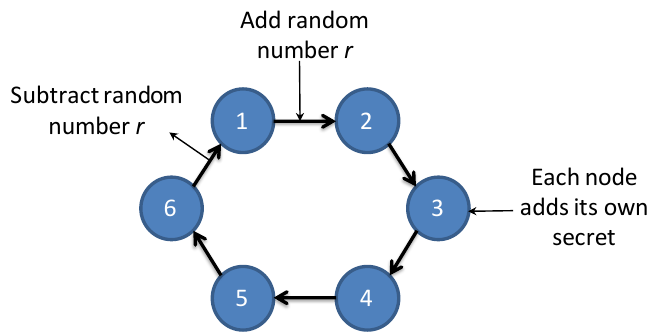
Figure 3. Secure Sum implementation